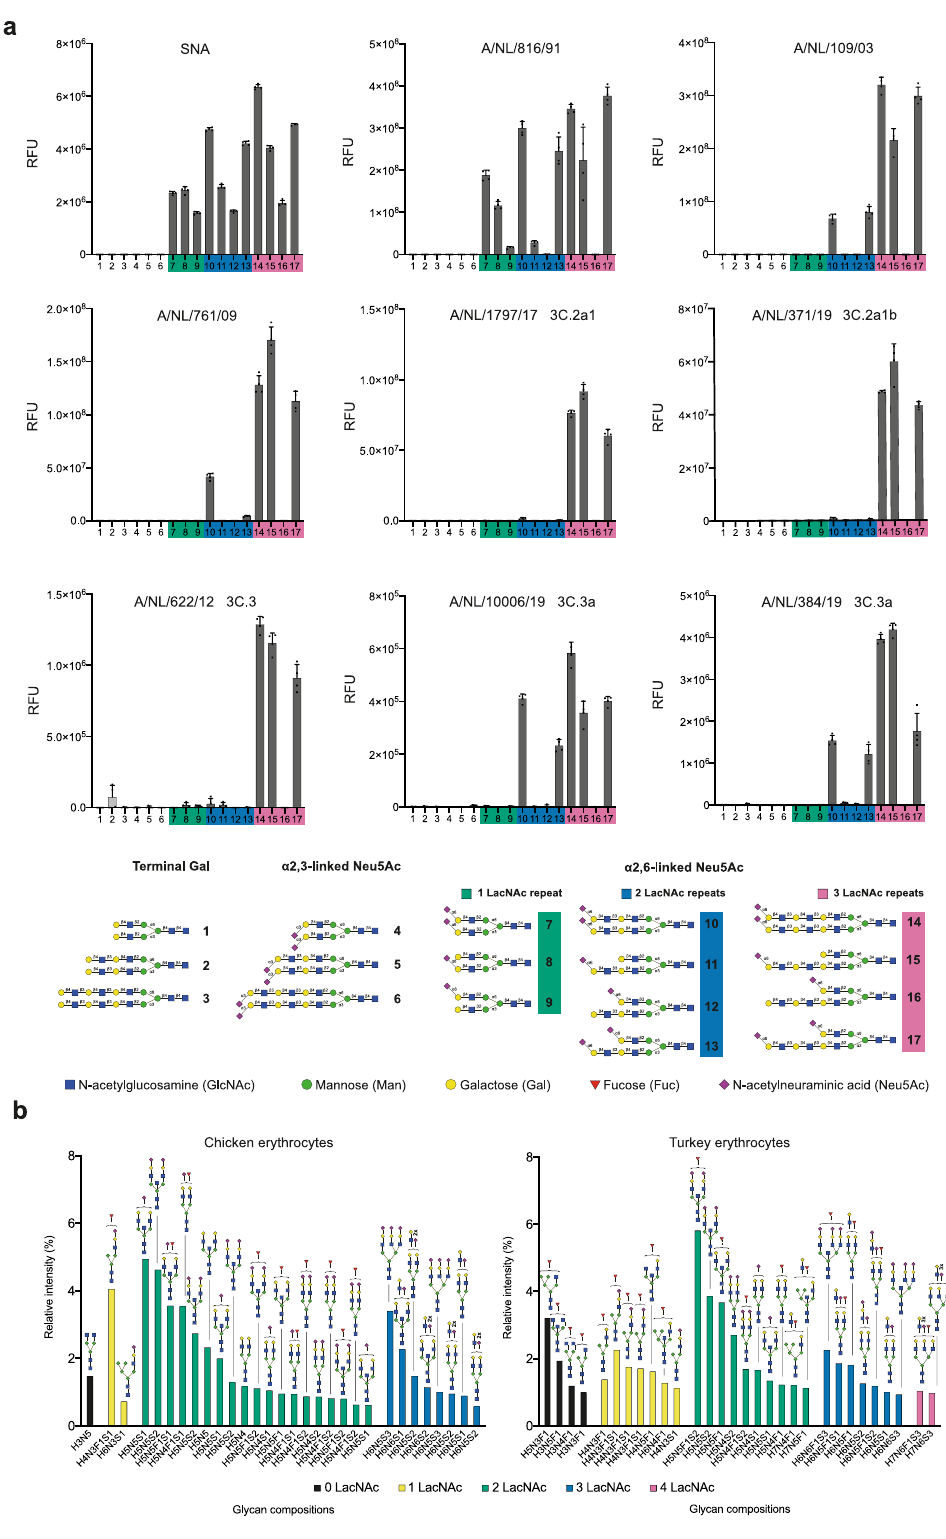
Fig. 1 Receptor-binding speci fi cities of representative A/H3N2 viruses using glycan microarray analysis and glycomic analysis of N -glycosylation of unmodi fi ed fowl erythrocytes. a Binding was visualized using a human anti-H3 stalk antibody (CR8020). Bars represent the background-subtracted average relative fl uorescence units (RFU) of four replicates ±SD. Values for all individual datapoints are represented in the Supplementary Source Data fi le. b The 30 most abundant N -glycans on erythrocytes from chicken and turkey organized by the number of LacNAc repeating units and relative intensity. High-mannose type N -glycans are not shown and their abundance is presented in Supplementary Fig. 5. The structures of all detected glycans are shown in Data